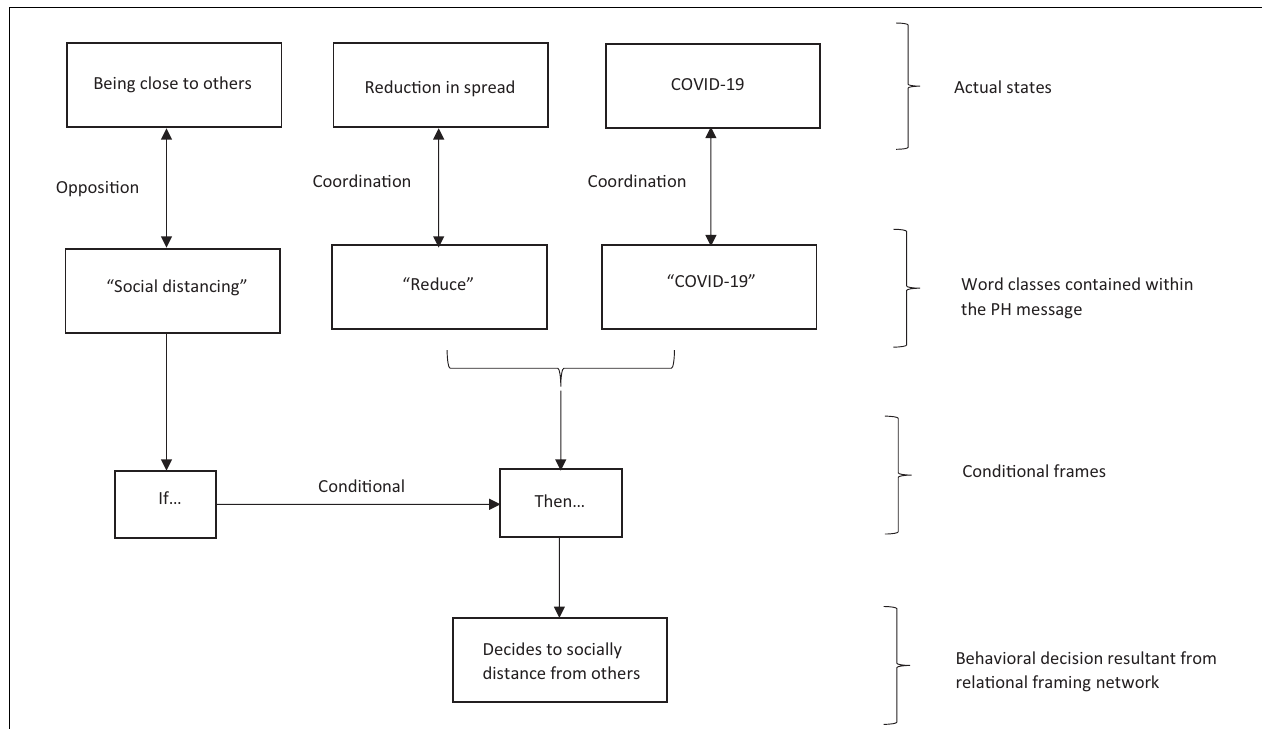
FIGURE 5 | A schematic representation of a relational framing network formed from reading a PH social distancing message, as suggested by the standard RFT model. Figure is redrawn and adapted from Stapleton (2020), permission granted from